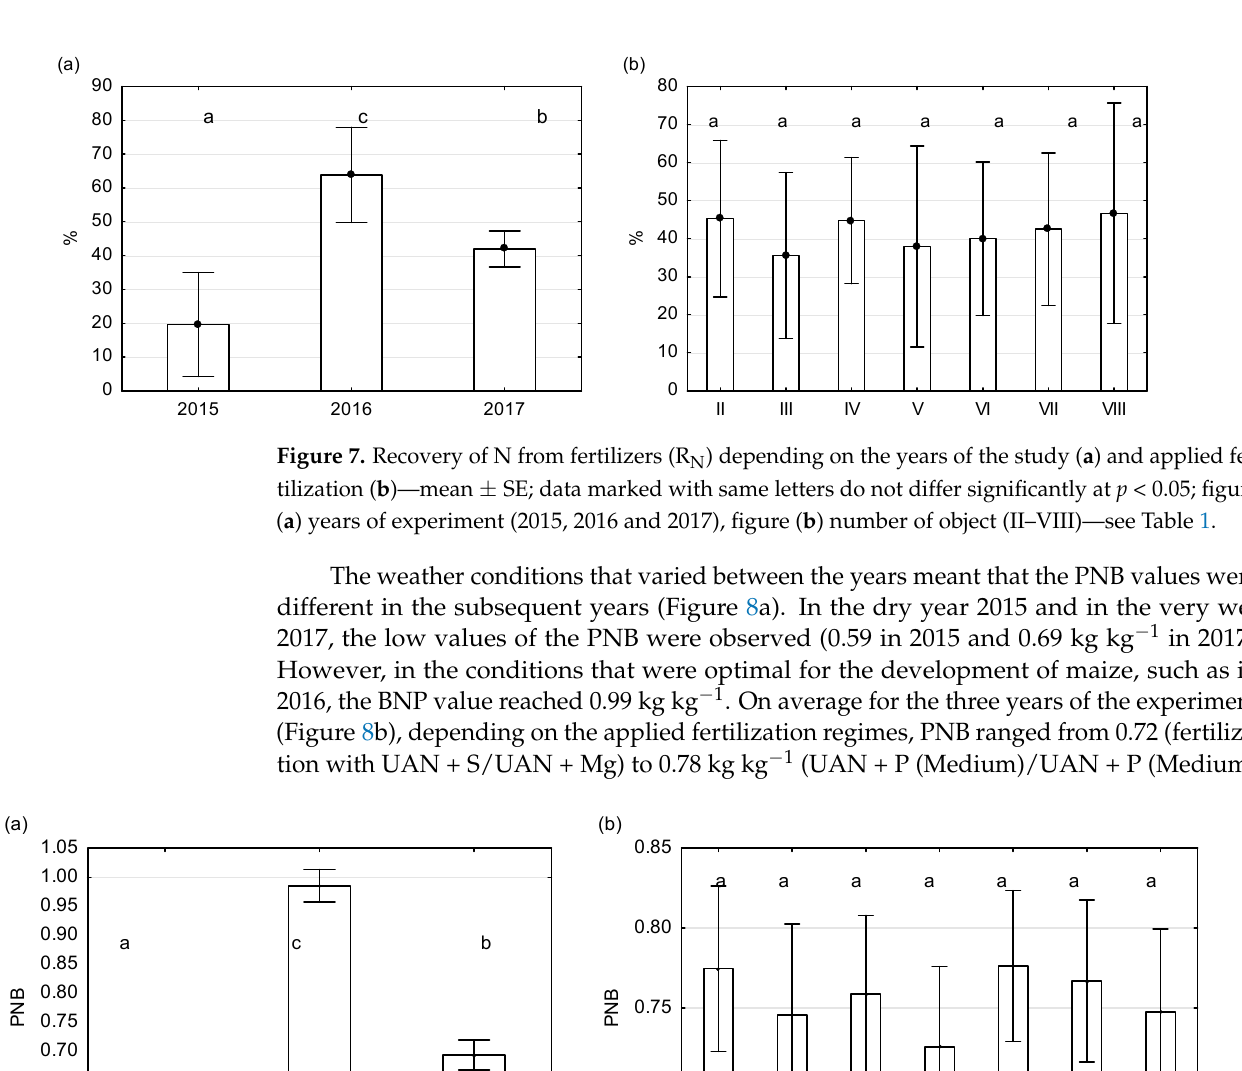
not significant statistically.